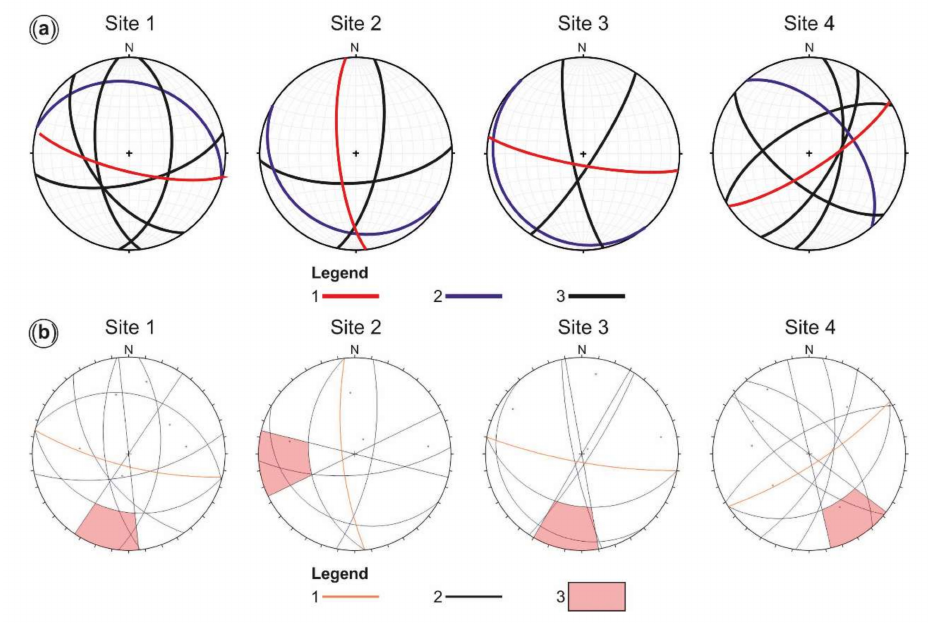
Figure 13. ( a ) Plots of the main discontinuity sets (strata and joints; lower hemisphere projection); for investigation sites’ locations see Figure 11. Legend: (1) Slope orientation; (2) strata attitude (S0); (3) main joints (J1,2,3,4); ( b ) markland test plot. Legend: (1) Slope orientation; (2) discontinuity sets; (3) potential toppling